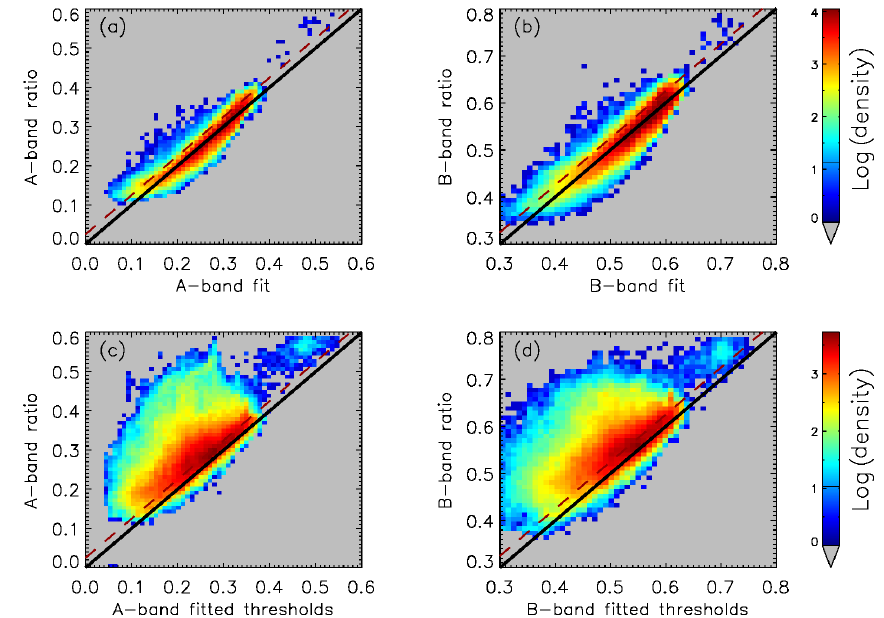
Figure 5. Scatter plot of regression fit versus A-band (a, c) and B-band (b, d) ratios for clear-sky (a, b) and cloudy-sky (c, d) pixels from EPIC measurements over global snow and ice surfaces in January and July 2017. The regression is derived with clear-sky oxygen band ratio as a function of surface elevation and air mass. The pixels on the left (b, d) side of black lines could be identified as cloudy (clear) as the observed ratio is larger (smaller) than the predicted threshold. The dashed lines (increase the predicted ratios by 0.025) provide better division of clear and cloudy pixels.